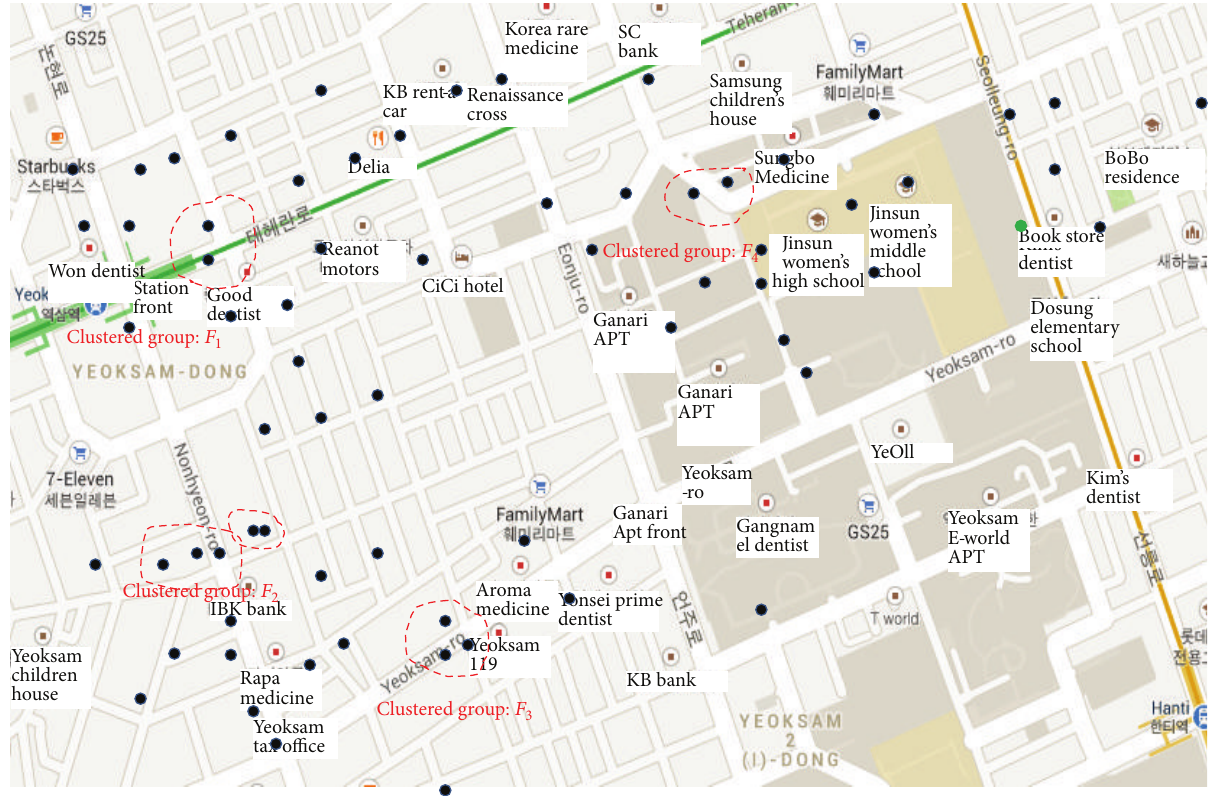
Figure 6: Clustered groups for the significance test.